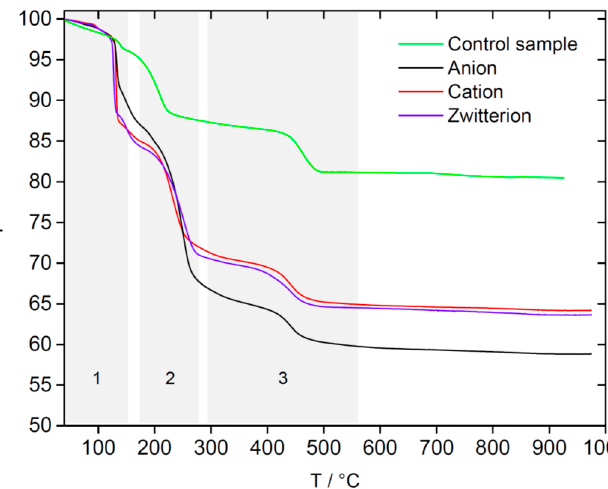
Figure 6. TGA curves obtained from samples grown with 100 mM precursor solution and 1 mg/mL of the respective polymers. Gray areas highlight the different decomposition steps. 1: water/solvent loss up to 140 °C (150 °C for the control sample); 2: overlapping further dehydration/condensation and cellulose decomposition steps up to 290 °C (240 °C for control sample); 3: final decomposition and pyrophosphate formation up to 550 °C.